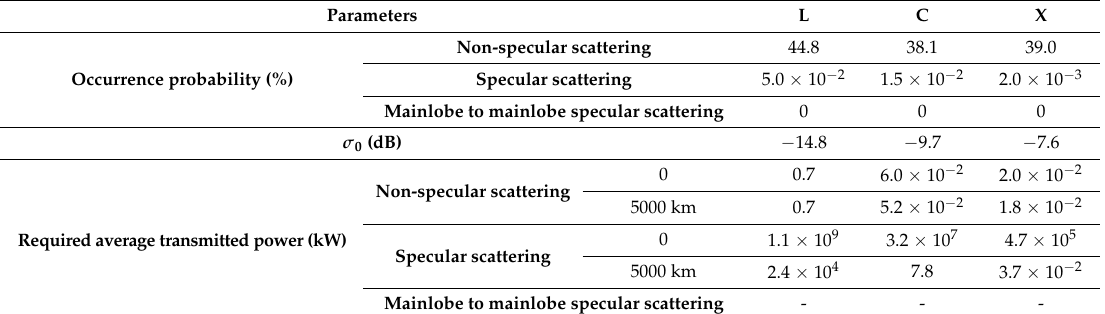
Table 5. Occurrence probability of the LEO SAR bistatic scattering RFI and the average transmitted power requirement in GEO SAR (HH polarization, Shrub scene, in the specular